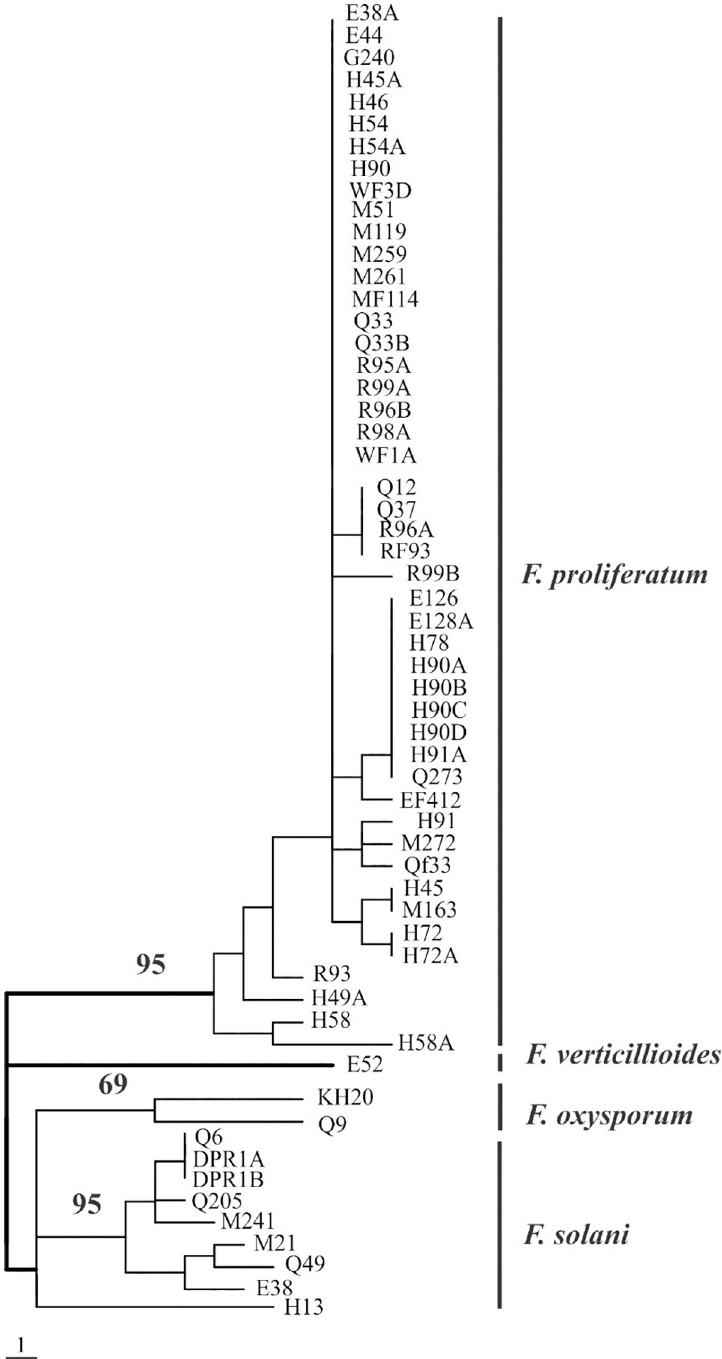
Fig 2. An UPGMA tree showing the relationship of 59 strains of Fusarium isolated from date palm trees and genotyped with SSR markers. Numbers on tree branches indicate the percentage of bootstrap values based on 1000 replicates. Bar scale at the bottom of the tree represents one SSR allele